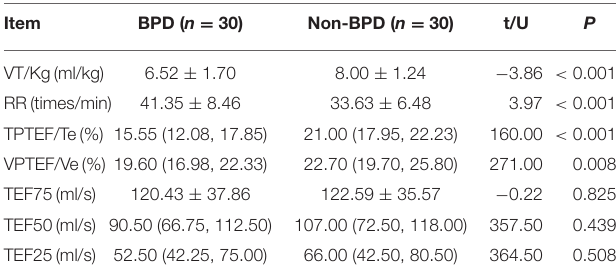
TABLE 1 | Lung function analysis in the BPD and non-BPD groups.